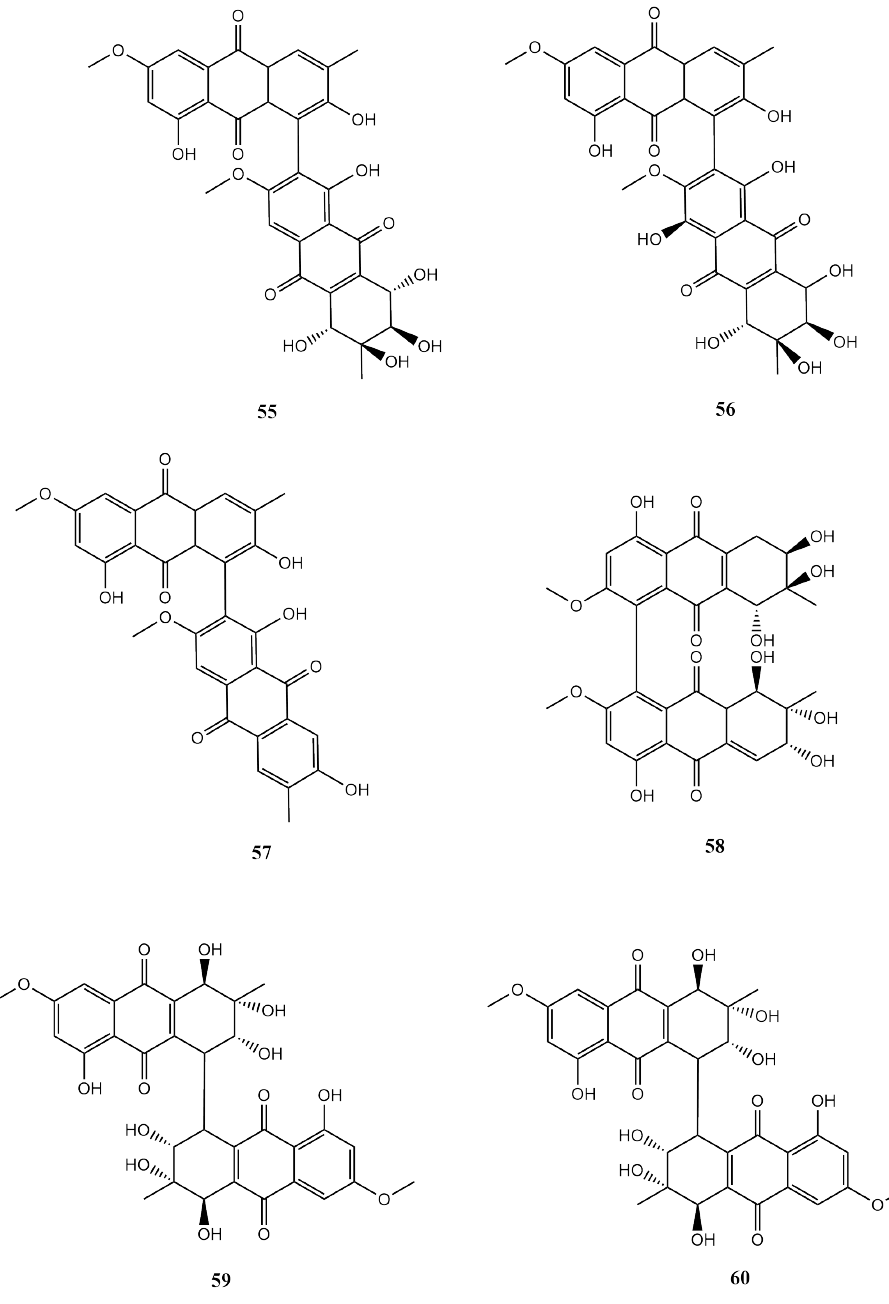
Figure 5. The chemical structures of the reported